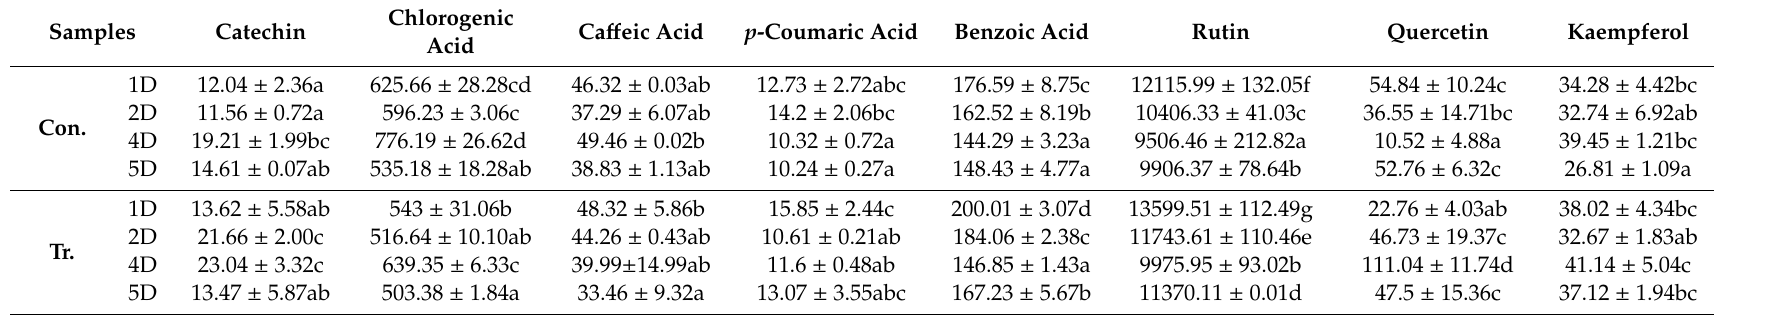
Table 2. The contents of flavonoids in tartary buckwheat in response to salt stress ( µ g / g dry